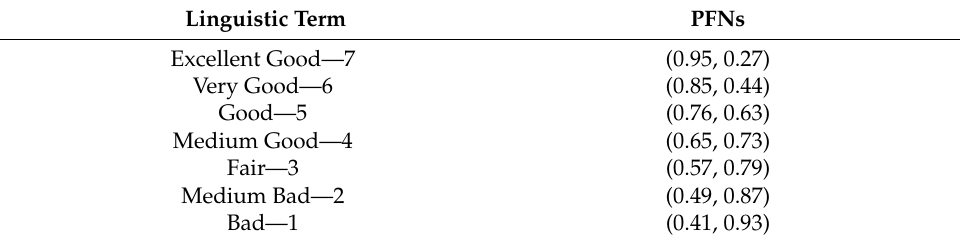
Table 4. Linguistic terms for rating